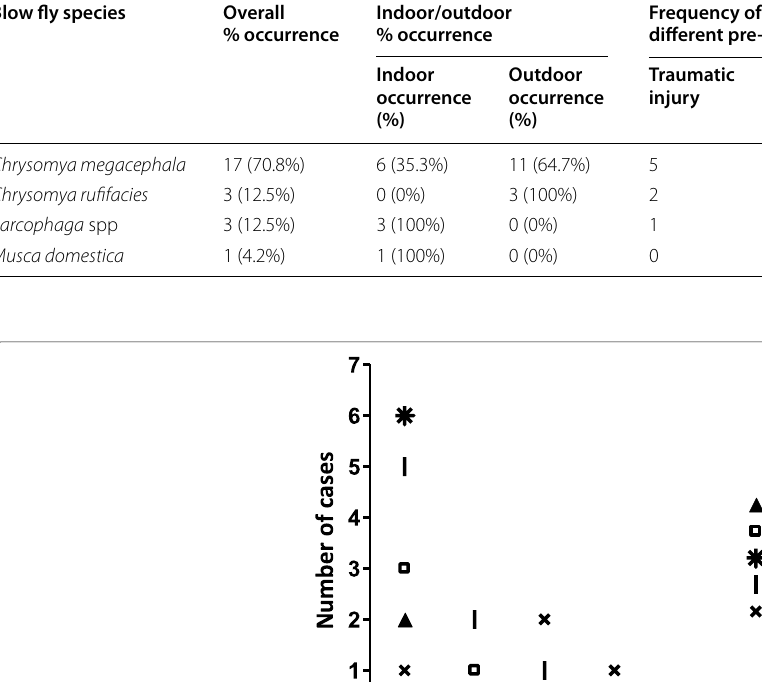
Table 2 Frequency of occurrence of necrophagous flies of forensic importance from various medico-legal cases in Tamil Nadu State, India